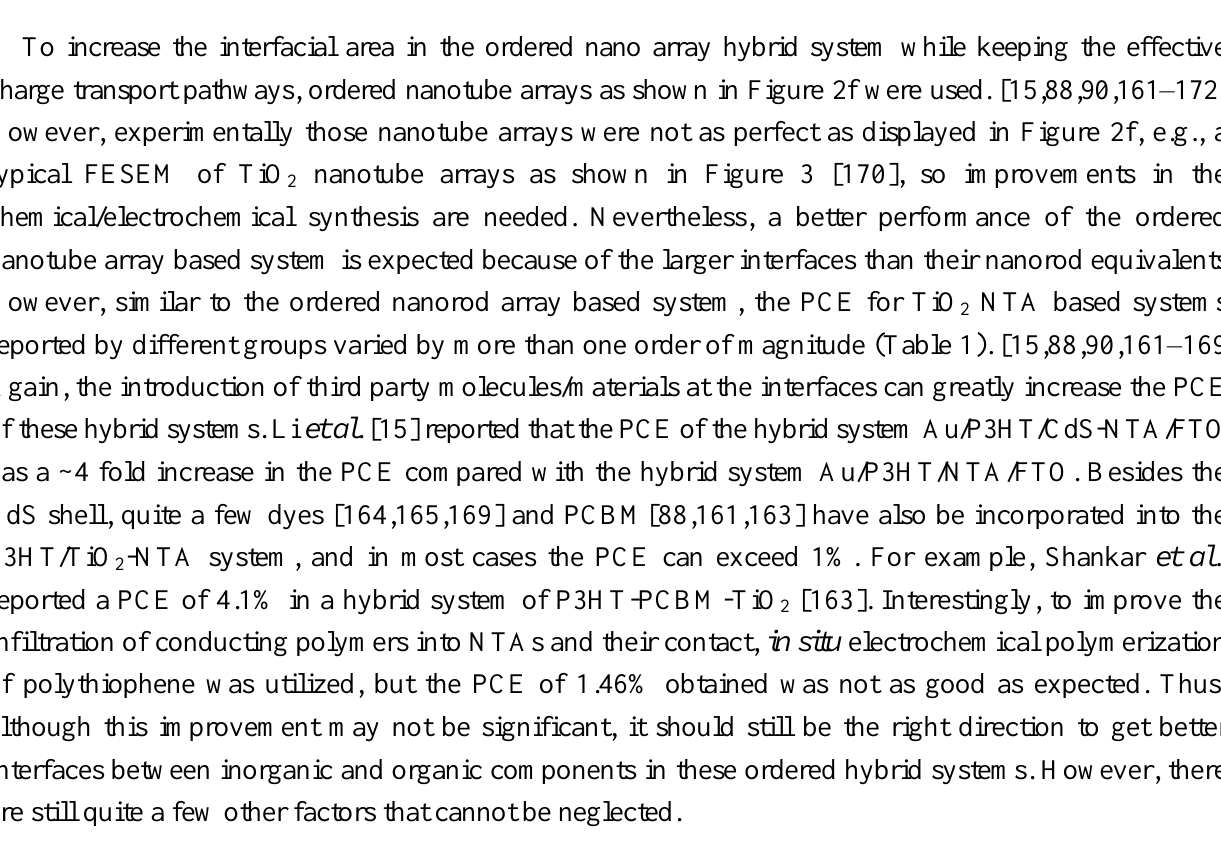
Table 1. Photovoltaic materials, structures and